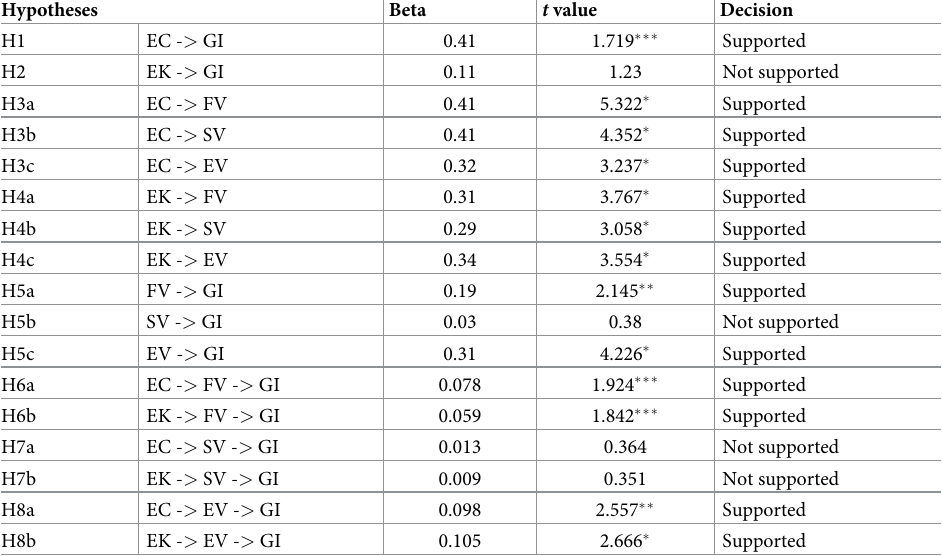
Table 7. Hypothesis testing.